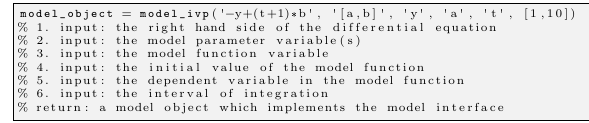
Listing 2. Create a model with a model function given as solution of an initial value